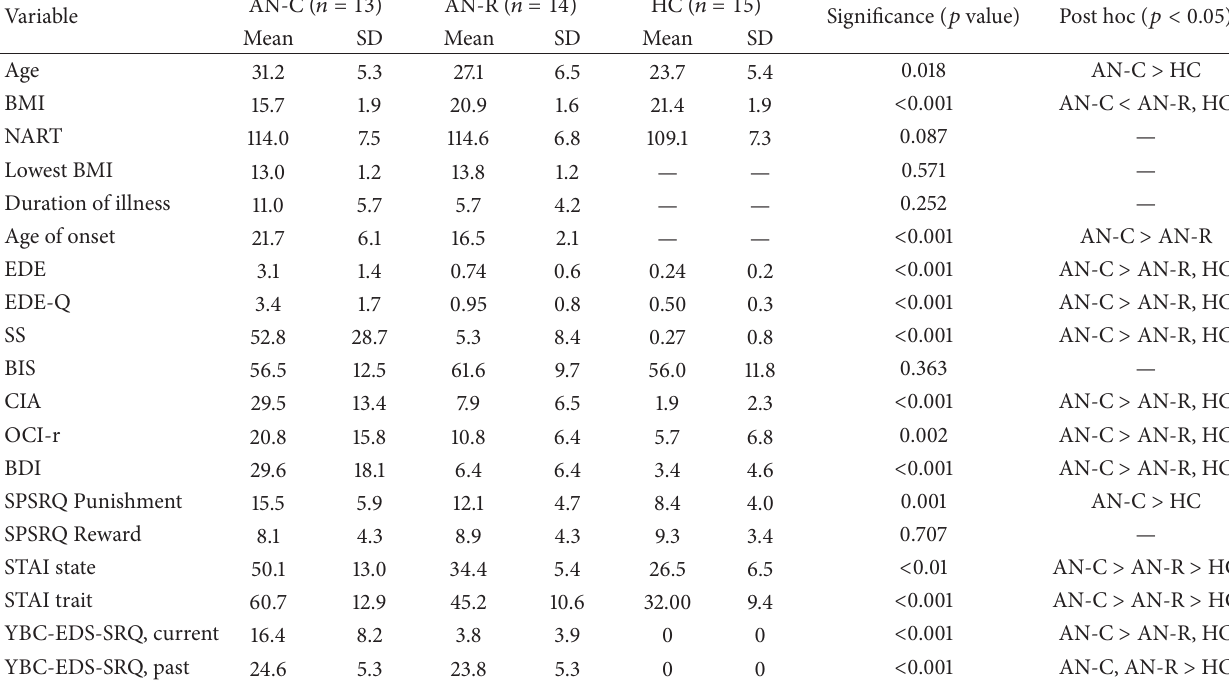
Table 1: Demographic and psychological characteristics stratified by